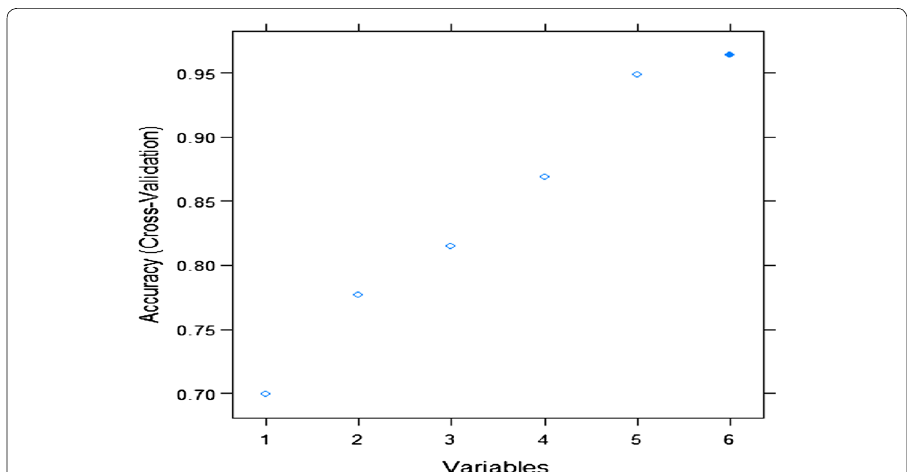
Fig. 7 The important measure for each variable of the Car Evaluation dataset using RecursiveFeatures Elimination